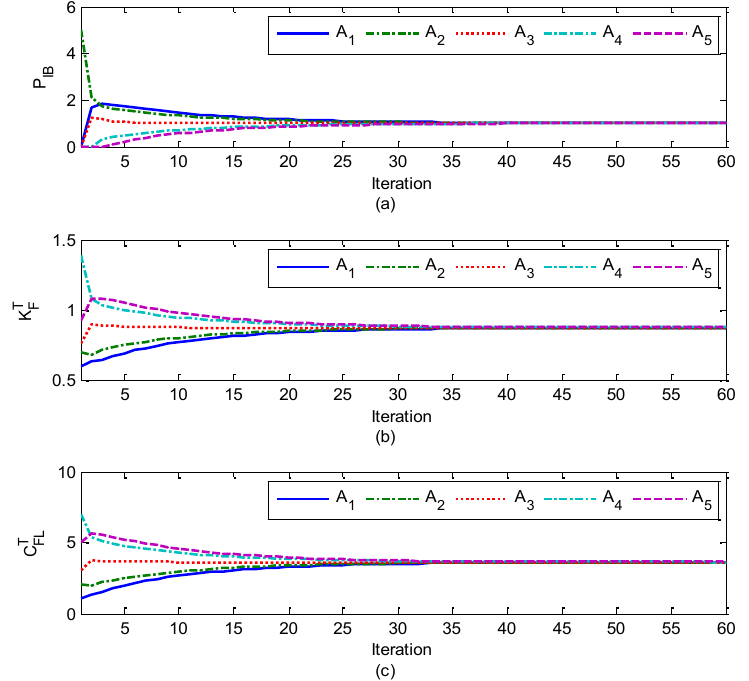
Figure 3. The distributed global information processing of Case A. ( a ) The information processing of the active total power imbalance P ; ( b ) the information processing of the IB total cost coefficient K T ; ( c ) the information processing of the total amount of flexible F loads C T FL